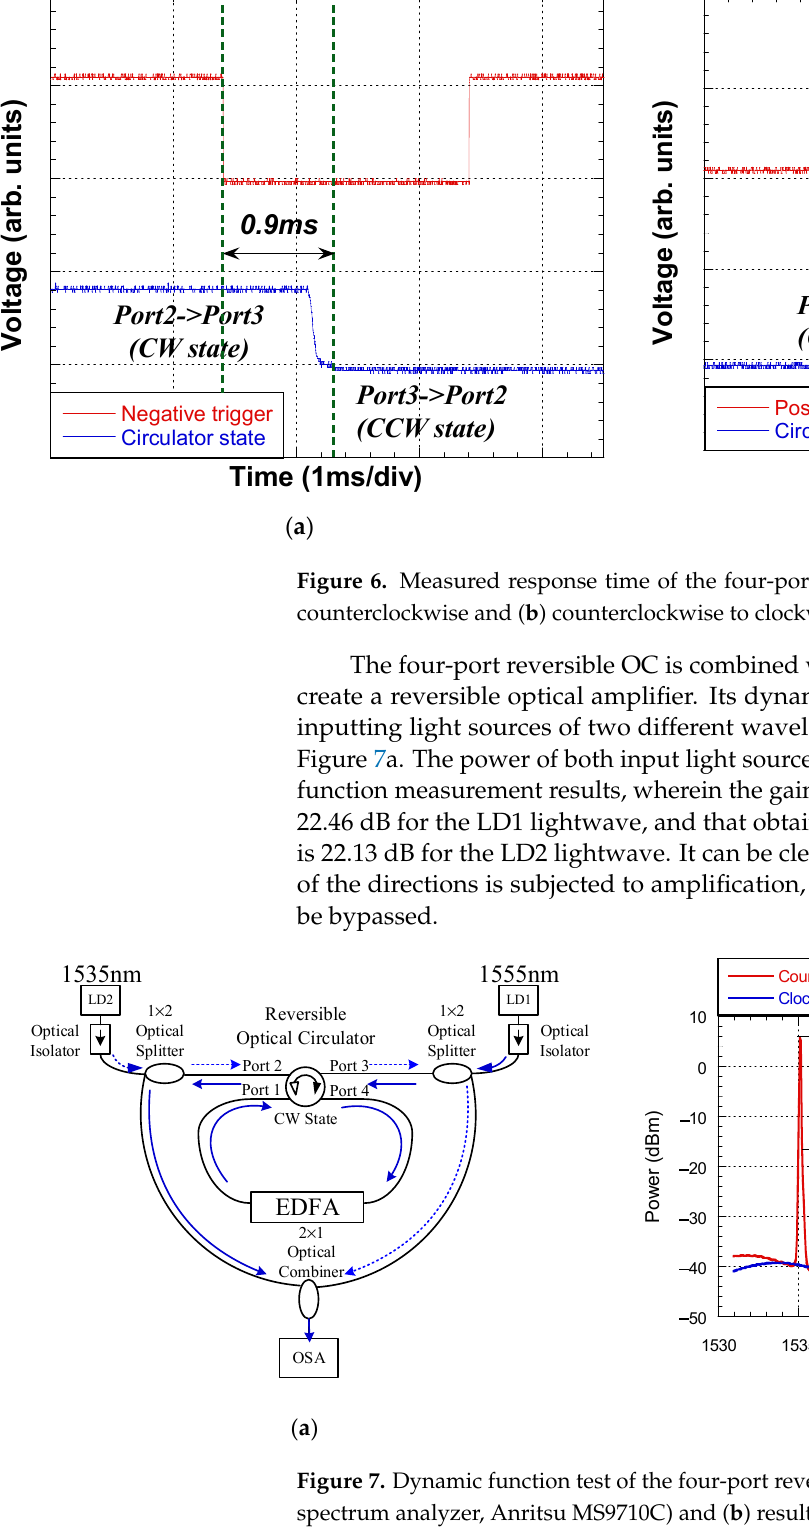
Figure 5. Measurement setup for the response time of the self-made four-port reversible optical cir- culator.